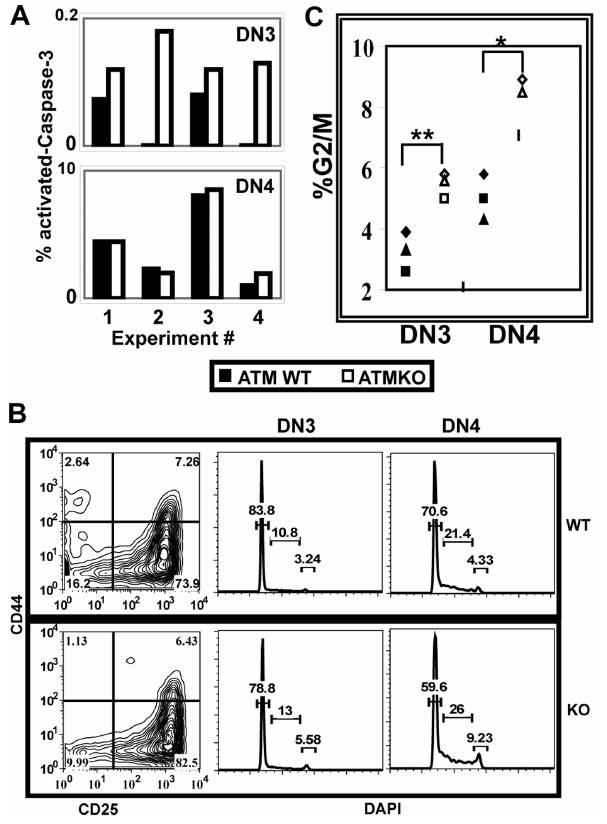
Figure 4. ATM deficiency alters cell survival and proliferation in DN cells. Freshly explanted thymocytes were stained for surface molecules, fixed, and permeabilized prior to intracellular staining. ( A) As compared to ATMWT, ATMKO DN3 but not DN4 cells have an increased frequency of cleaved-Caspase-3 + cells (ATMWT vs KO DN3 p , 0.03). Graphs show frequencies of ATMWT (grey bar) and KO (white bar) lineage negative DN3 and DN4 cells that express cleaved-Caspase-3. Data from four independent experiments analyzing ATMWT and KO pairs is shown. (B) Panels show representative lineage negative CD25 CD44 DN staining profiles for ATMWT (top panel) and KO (lower panel) thymi and DAPI staining profiles gated on DN3 and DN4 cells. (C) Frequency of DN3 and DN4 cells from individual ATMWT (black symbols) and KO (open symbols) mice that are in G2/M of the cell cycle. ATM deficiency results in increased cycling cells in both DN3 and DN4 stages (p , 0.002 and 0.02, respectively). P values were calculated using Student’s paired 1-tailed t test from data collected from three-four ATMWT and KO pairs analyzed in three independent experiments. doi:10.1371/journal.pone.0062188.g004 linking the requirement for ATM during endogenous TCR b rearrangement to defects in development at the b -selection checkpoint.